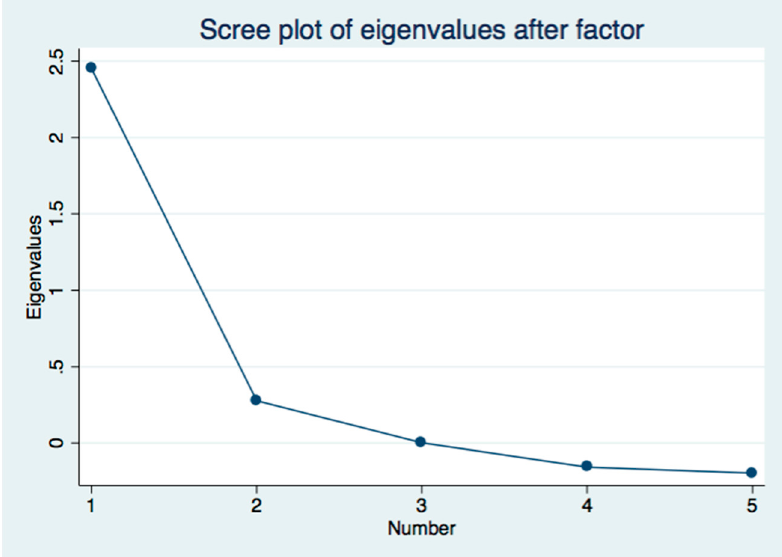
Figure 1. Scree Plot for Neighborhood Advantage Score.